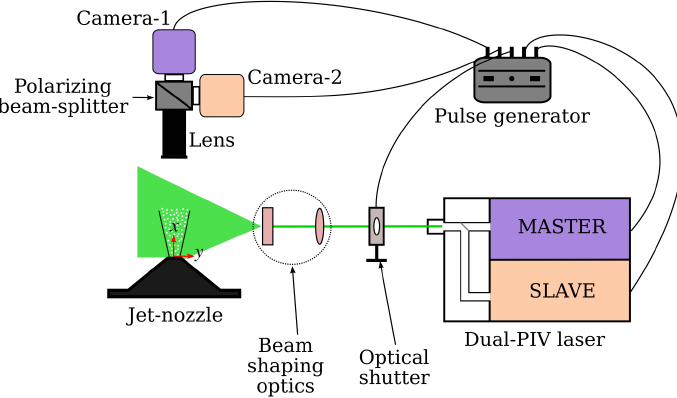
Figure 2. Schematic of the experimental